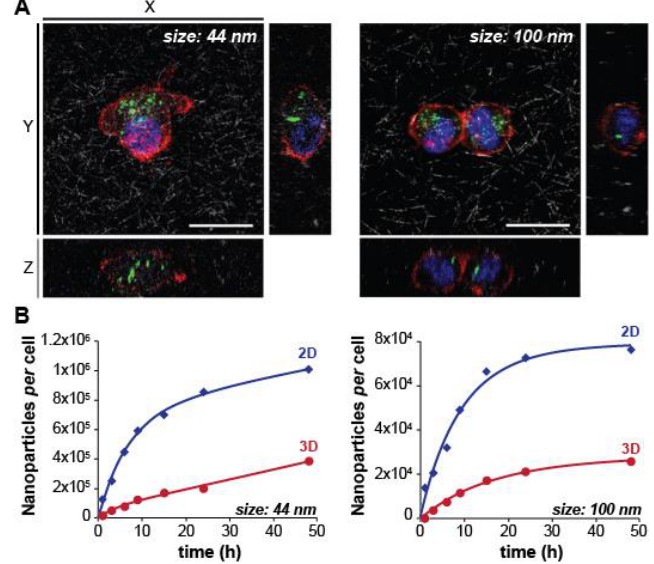
Figure 6. ( A ) Confocal microscopy maximum projection of Z-stack sections, obtained by confocal microscopy, of HT1080 cells incubated with 44 nm and 100 nm nanoparticles (NPs) for 24 h in 3D collagen matrix. Cell nuclei are shown in blue, actin microfilaments in red, NPs in green and collagen fibers in grey. Scale bar: 10 µm. ( B ) Uptake kinetics of 44 nm and 100 nm NPs by human epidermal fibroblasts (HDF) cells during continuous exposure to the nanoparticles, as determined by spectrophotometric analysis. Data points and error bars represent the mean and standard deviation over three replicas. Adapted from Reference [88], with permission from Elsevier B.V. © 2020.